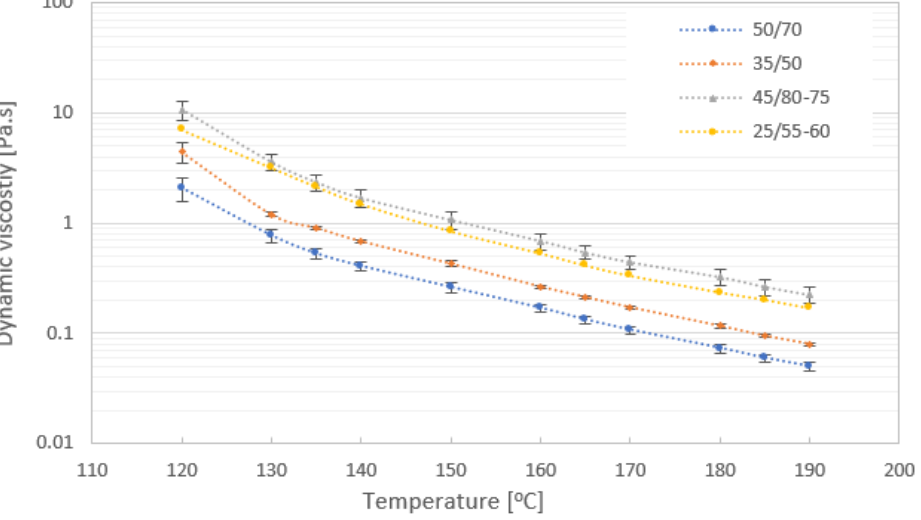
Figure 5. Dynamic viscosity results of tested bitumen samples 50/70 gradation, 35/50 gradation, modified bitumen samples 45/80-75 and 25/55-60.